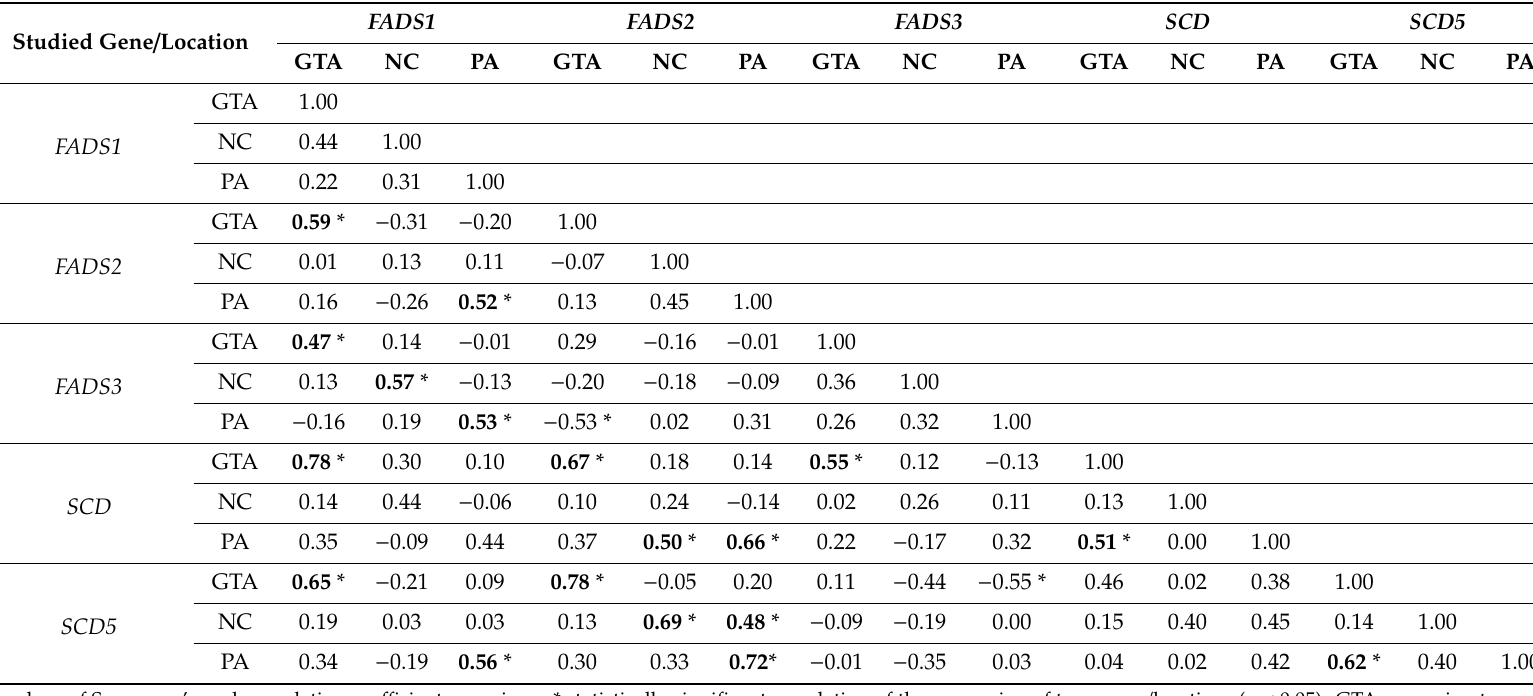
Table 4. Correlations between the mRNA expression of all studied desaturase genes in all three tumor zones, using GAPDH gene as reference. Studied Gene /